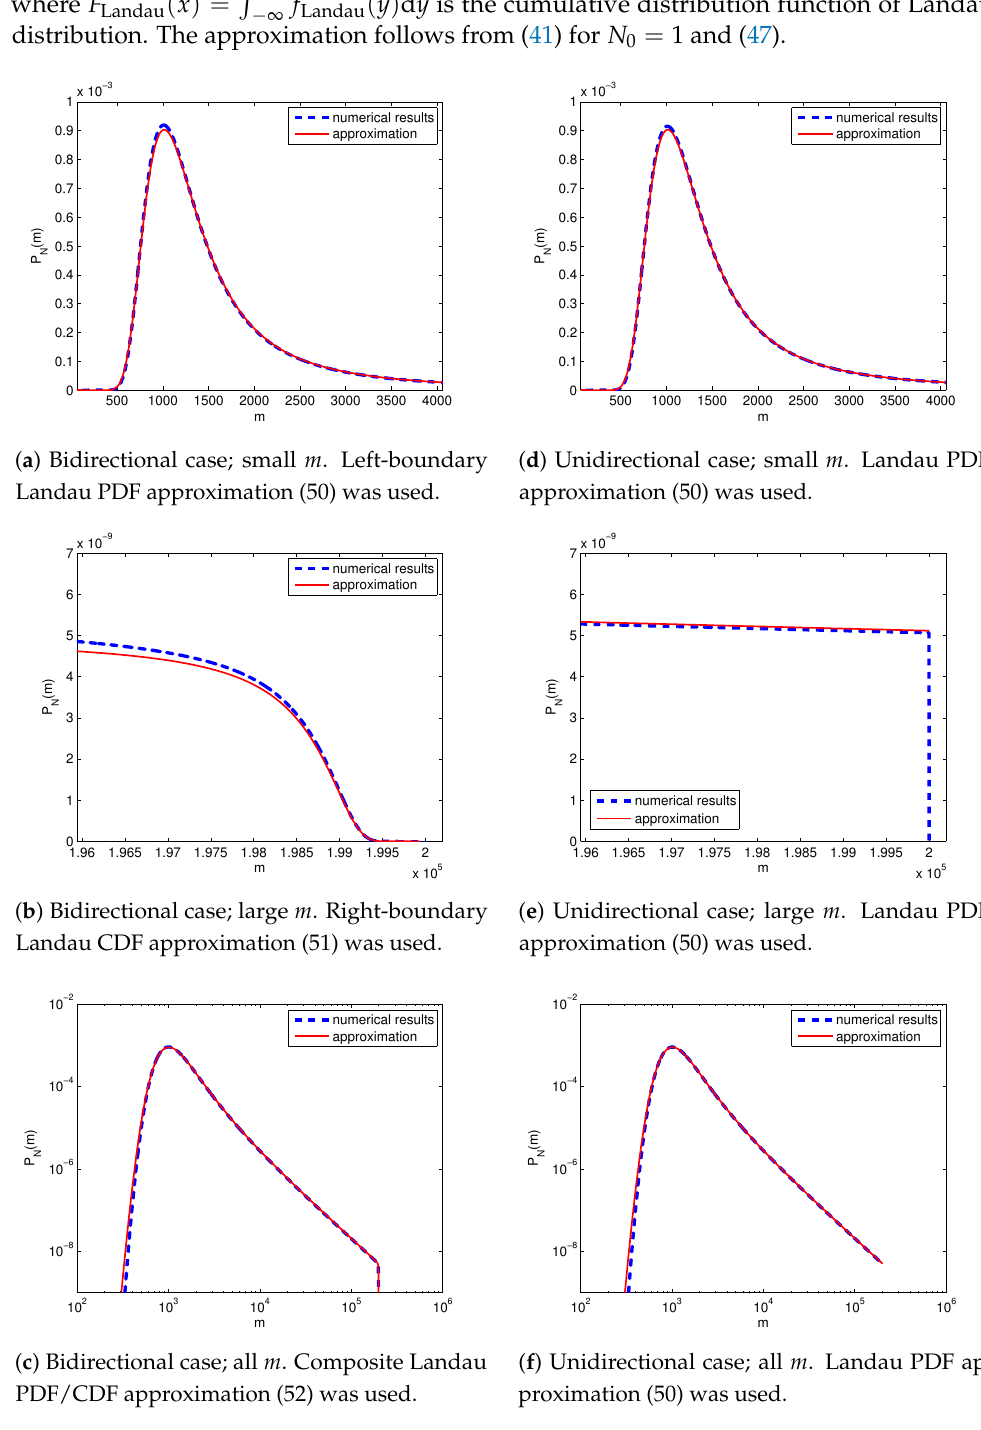
Figure 3. The probability P N ( m ) of having m resistant cells in a total population of N cells as calculated numerically (blue dashed lines) and its asymptotic approximations (50), (51), (52) (red solid lines). The population started from a single sensitive cell and was left to grow until it had consisted of N = 2 × 10 5 cells. ( a – c ) Bidirectional case: the probabilities of resistance acquisition and loss were µ = λ = 10 − 3 . ( d – f ) Unidirectional case: µ = 10 − 3 , λ =